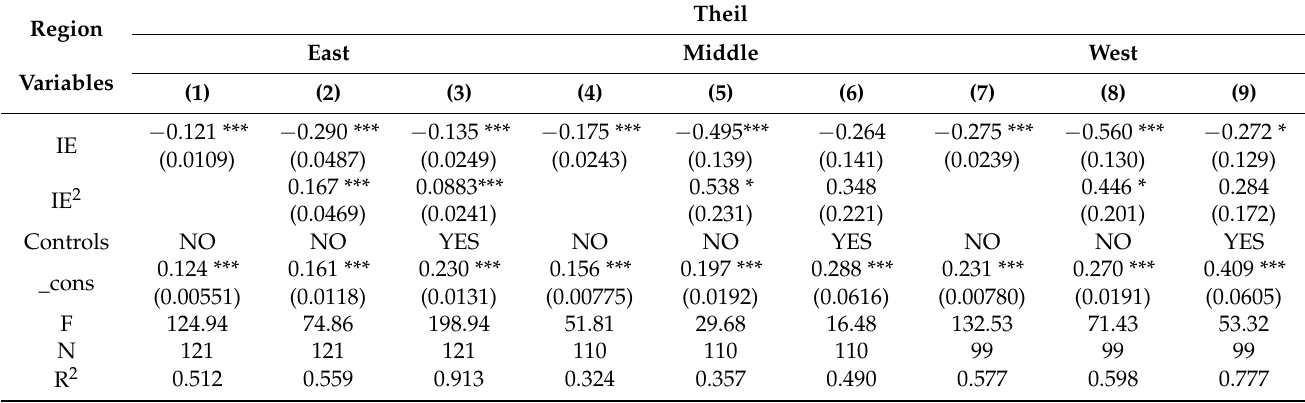
Table 6. Regional